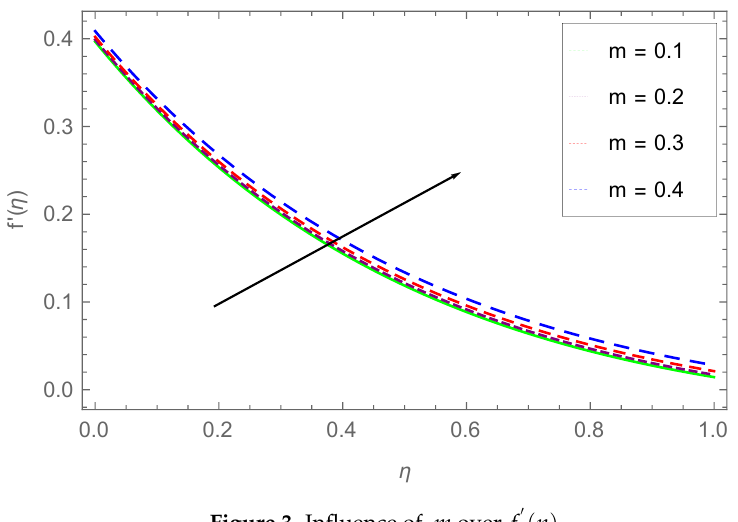
Figure 3. Influence of m over f (cid:48) ( η ) .